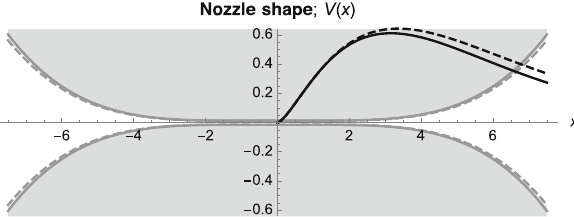
Fig. 3 The nozzle profile for s = (cid:20) = 2. The gray filled area , limited by the continuous ( dashed ) line denotes the de Laval nozzle in the Schwarzschild, GR σ → ∞ , limit (in the minimal geometric deformation of the de Laval nozzle). The black lines represent V ( x ) for the GR limit ( continuous line ) and its minimal geometric deformation ( dashed line ) bound | ς | (cid:3) 8 . 2 × 10 − 5 on the minimal geometric deforma- tion parameter